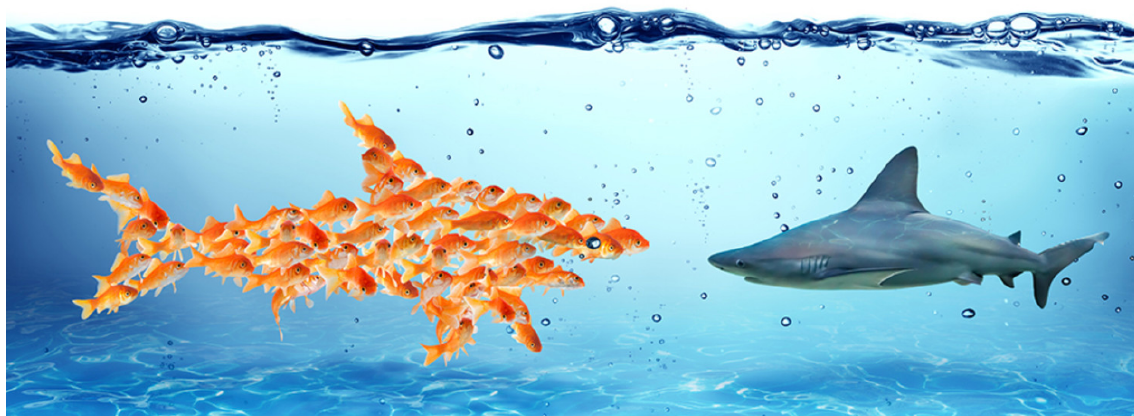
Fig. 1 . Service SCM - Systems as a service - whole is greater than the sum of the parts 7 Advanced R&D at the bleeding edge may be sequestered by the upper crust of the supply chain. But, pragmatic innovation can re-shape the outcome to serve the rest of the world, where the mega markets exist – excluding US, EU and JP (which represents 10% of the